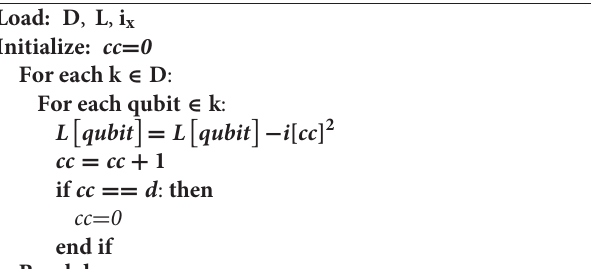
Algorithm 2 Instance to cluster distance